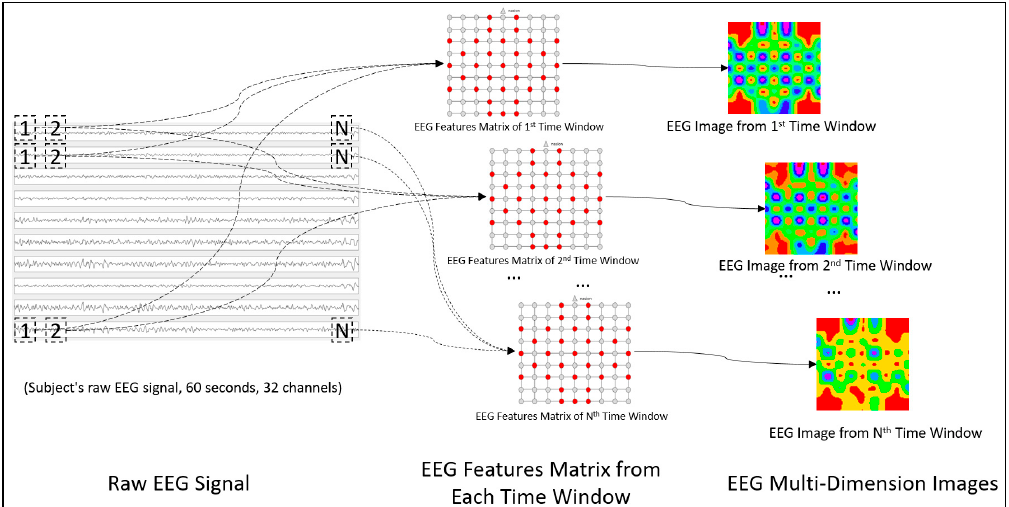
Figure 2. The construction process diagram of the electroencephalographic (EEG) Multidimensional Feature Image (MFI) sequence.